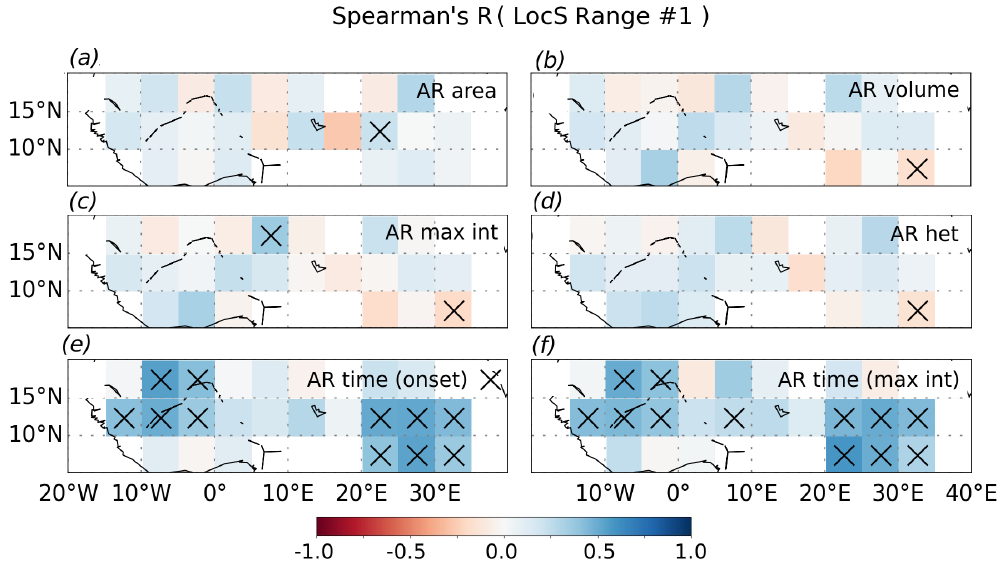
Figure 4. Spatial distribution of the correlations between the rain properties and soil moisture heterogeneity. Spearman’s rank correlation coefficient between the soil moisture gradient, Se , and corresponding AR property value is estimated for each 5 × 5 degree grid box. Only the extreme negative LocS values (Range #1) are considered. Boxes with significant correlation ( p -value < 0.05) are marked with a cross. Grid boxes where the number of events is below 20 are masked